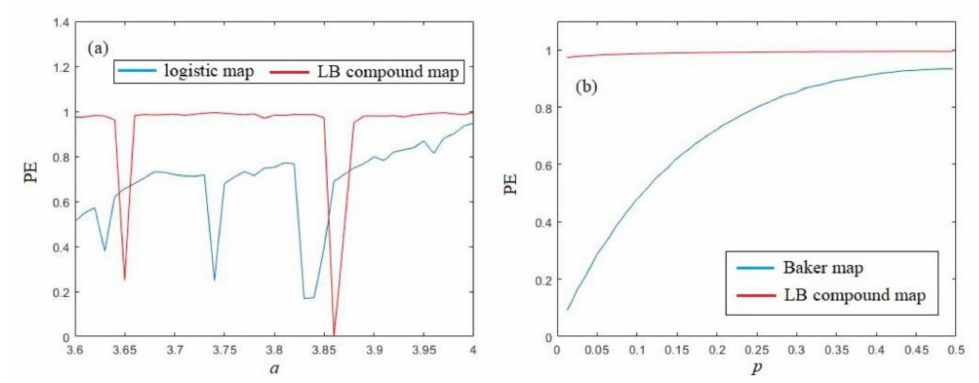
Figure 7. PE analysis of the LB compound chaotic map: ( a ) PE comaprison with logistic map ( b ) PE comparison with Baker